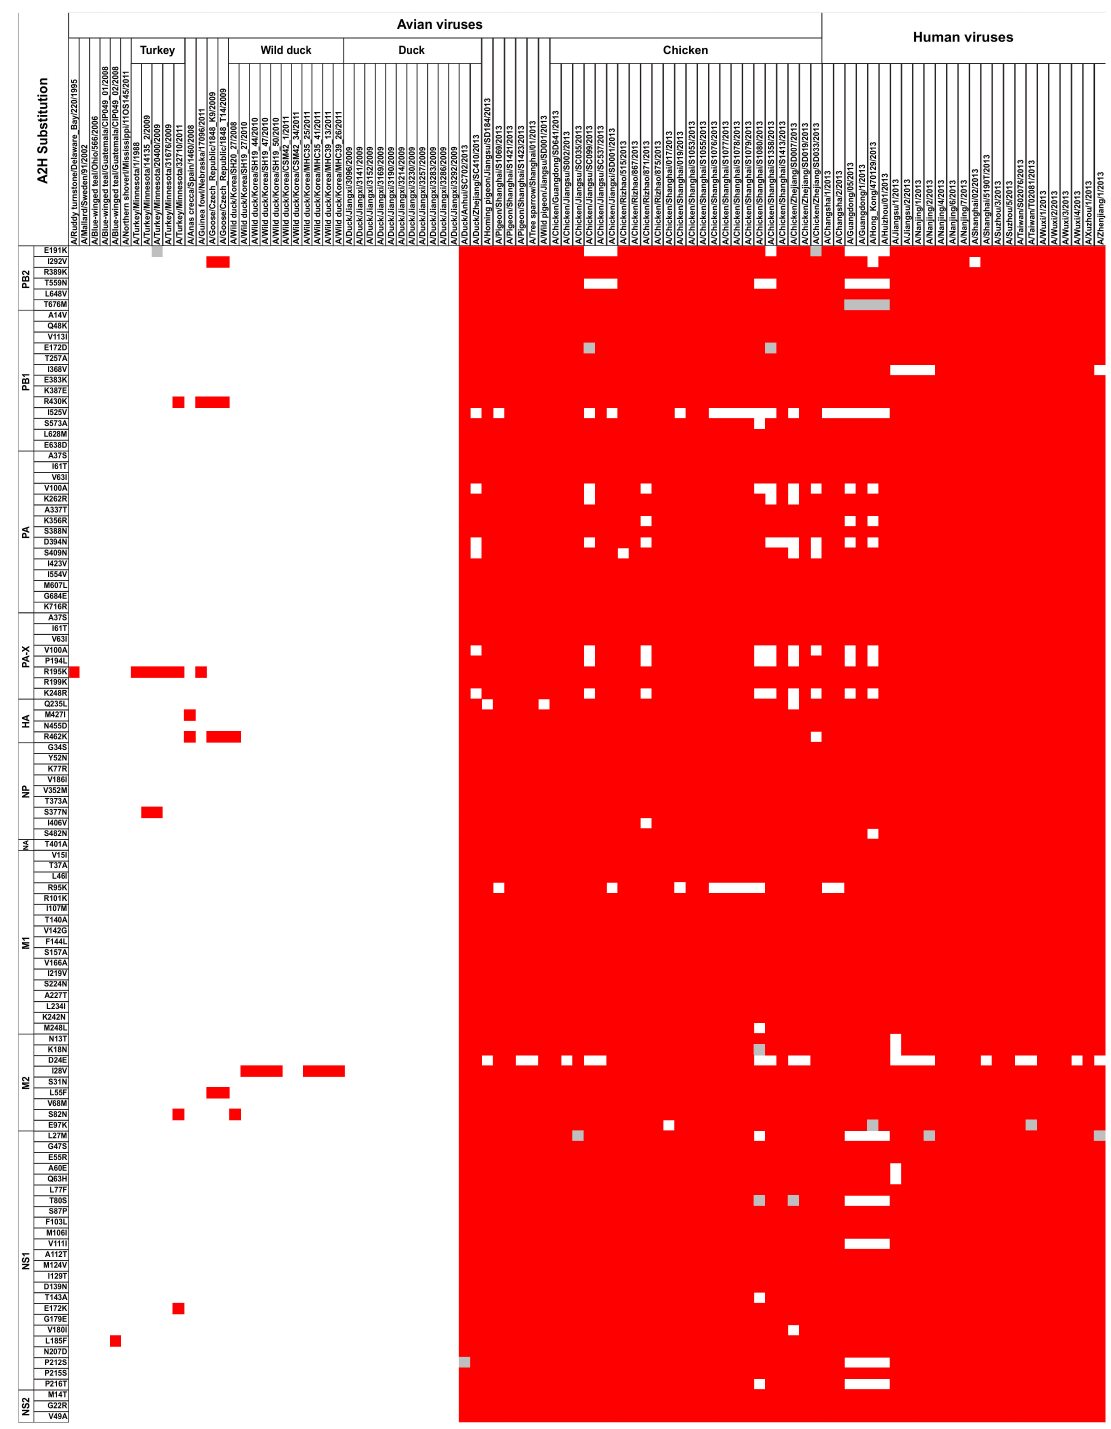
Figure 3. Heat map depicting the distribution of the 109 identified avian-to-human (A2H) substitution sites (rows) of publicly reported, full-length, avian and human influenza A (H7N9) virus strains (columns). The identified A2H amino acid (a.a.) substitutions are sorted according to the influenza A virus segments. The distribution is shown with red representing the presence of the A2H a.a. substitution (human index), white for avian index, and grey for strains that exhibited neither (i.e., other variants) or the presence of a gap at the respective position. Eurasian teal is referred to here with the scientific name Anas crecca . Do note that for the strain A/Goose/Czech Republic/1848_K9/2009, the complete proteome sequence was taken from FluDB, while for the other strains, the PA-X sequence was from FluDB and the other proteins were from GISAID. Full-length strains that could not be ascertained by the accession were